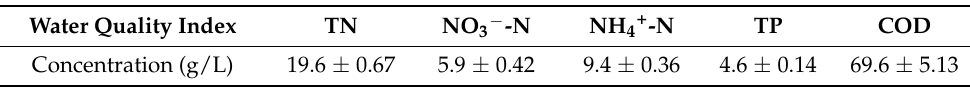
Figure 1. Reactor diagram of the integrated sewage treatment system. Table 2. Actual sewage